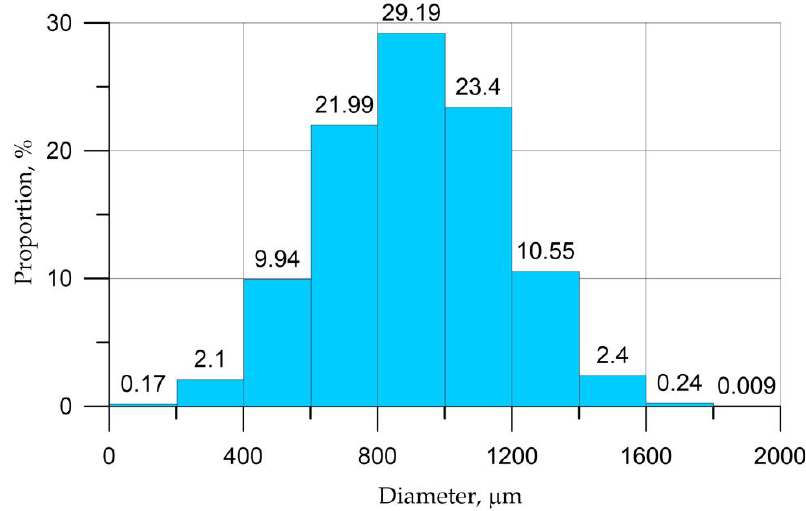
Figure 5. Distribution of particles at the entrances.